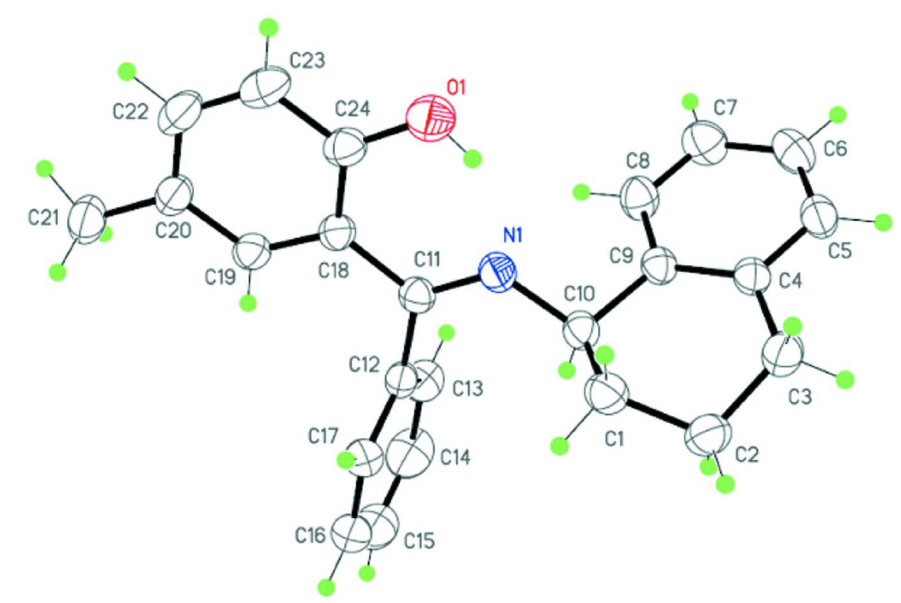
Figure 1 The asymmetric unit of (I), showing the atom-labelling scheme. Displacement ellipsoids are drawn at the 30% probability level and H atoms are shown as spheres of arbitrary